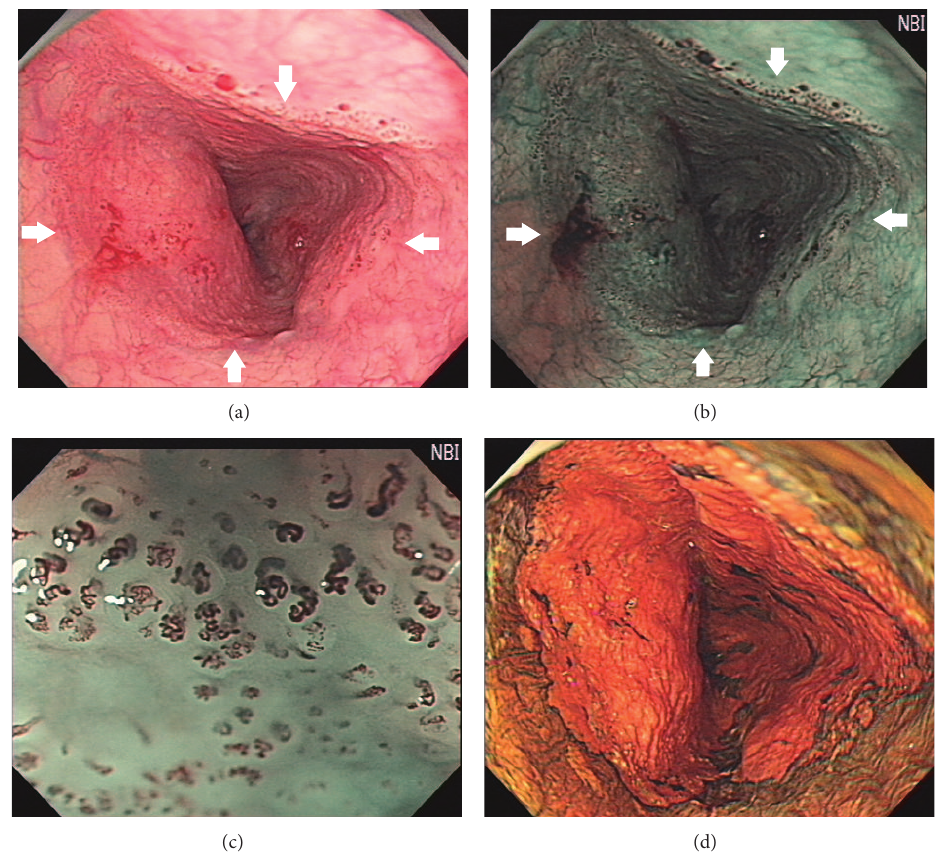
Figure 7: (a) Conventional endoscopy shows an esophageal circumferential long-segment neoplasia with hyperemic changes and nodularity of surface mucosa which turns to brownish discoloration (b) under narrow-band imaging system. (c) Under magnification with narrow-band imaging, abnormal superficial vessels are well demonstrated (Inoue’s classification type V 𝑁 ). (d) Chromoendoscopy with 1.5% Lugol’s solution shows extended Lugol-voiding